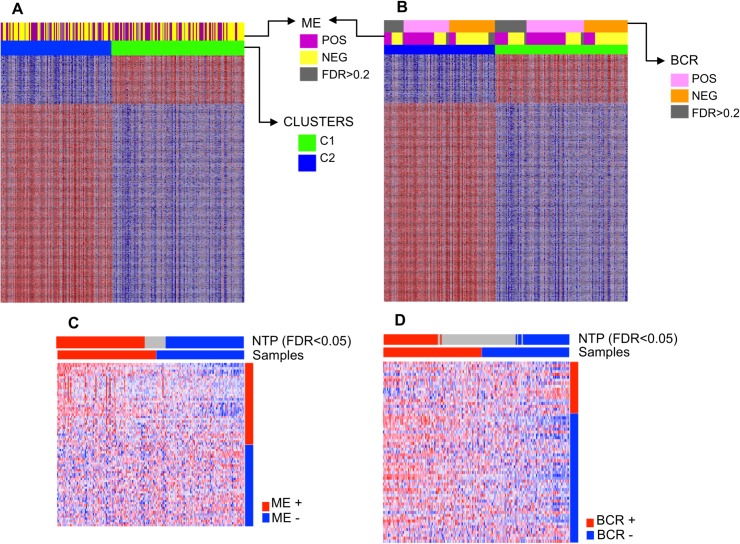
Heatmaps showing the association of clusters with A. microenvironment (ME) and B. BCR stimulation signatures. Both clusters showed a degree of ME and BCR signaling activation. Nearest template prediction (NTP) using C. microenvironment and D. BCR stimulation signature.